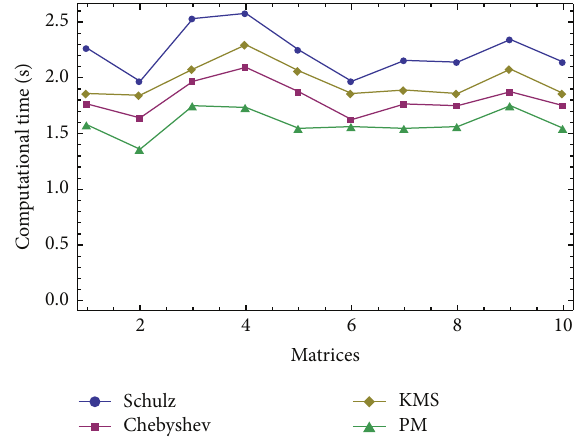
Figure 4: Comparison of the elapsed time for solving Example 9.